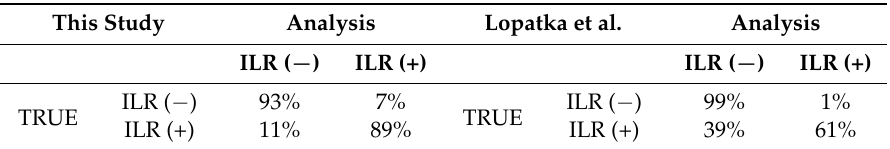
Table 7. Detection of ILs in fire debris samples with the true and false positives and negatives for this study and as reported previously [22] for the same data set ( n = 90, 45 substrate mixture burns without IL and 45 substrate mixture burns with IL).